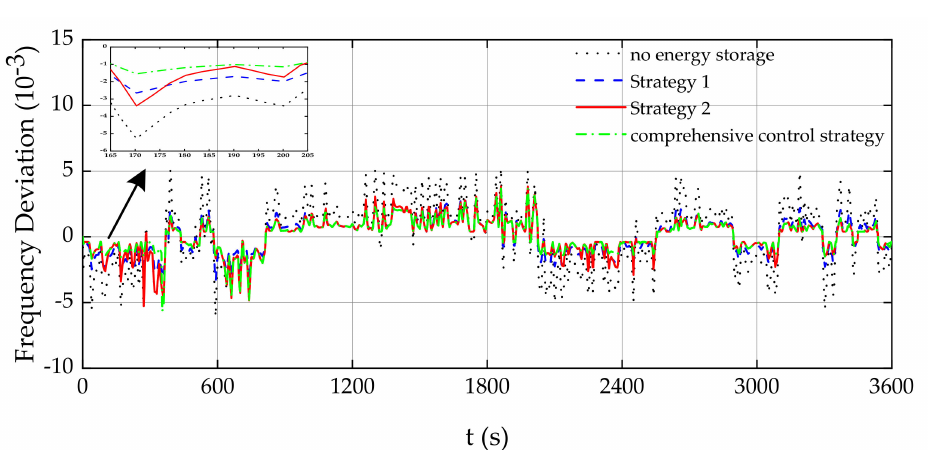
Figure 15. Frequency deviation curve under 60 min continuous load disturbance.